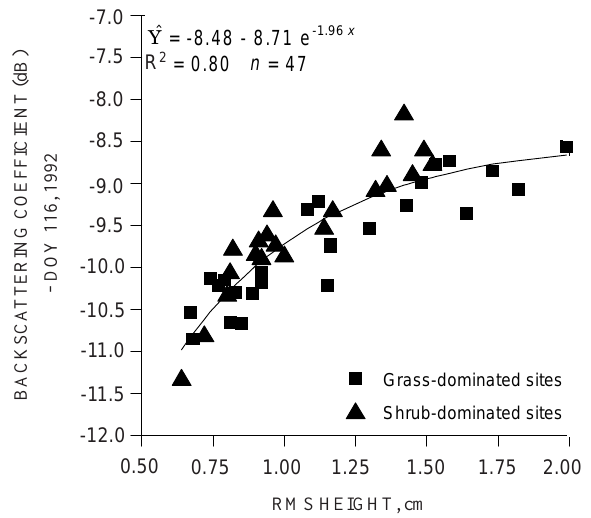
Figure 4. 1992 dry season backscattering coefficient dependence on soil roughness of the Walnut Gulch Experimental Watershed.